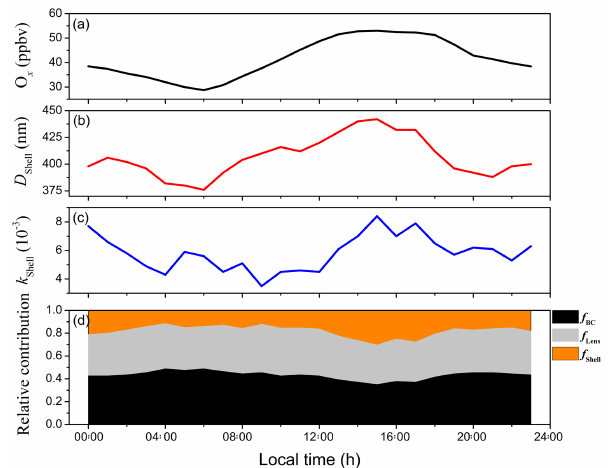
Figure 8. Scatter plot of E abs and ω for different photochemical ox- idant concentrations. Variation in the observed diurnally averaged absorption enhancement and SSA (solid points, colour-coded with respect to the concentrations of O x ) is used for the modelling con- straint. Both E abs and ω increase with O x mixing ratio. The open circles are the single-particle Mie theory calculation results with an optimized BC core size of 160nm. The CRI of BC was fixed at 1.85 + i 0.71. The real part of the CRI of the coating material was fixed at 1.55. The changes in the imaginary part of the CRI and the thick- ness of the coating material were colour-coded and shown as the different dimensions (open circle).